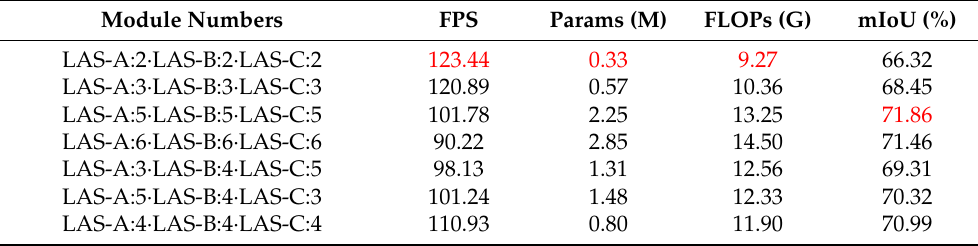
Table 5. Ablation studies of different module numbers. The red color font indicates the optimal result.